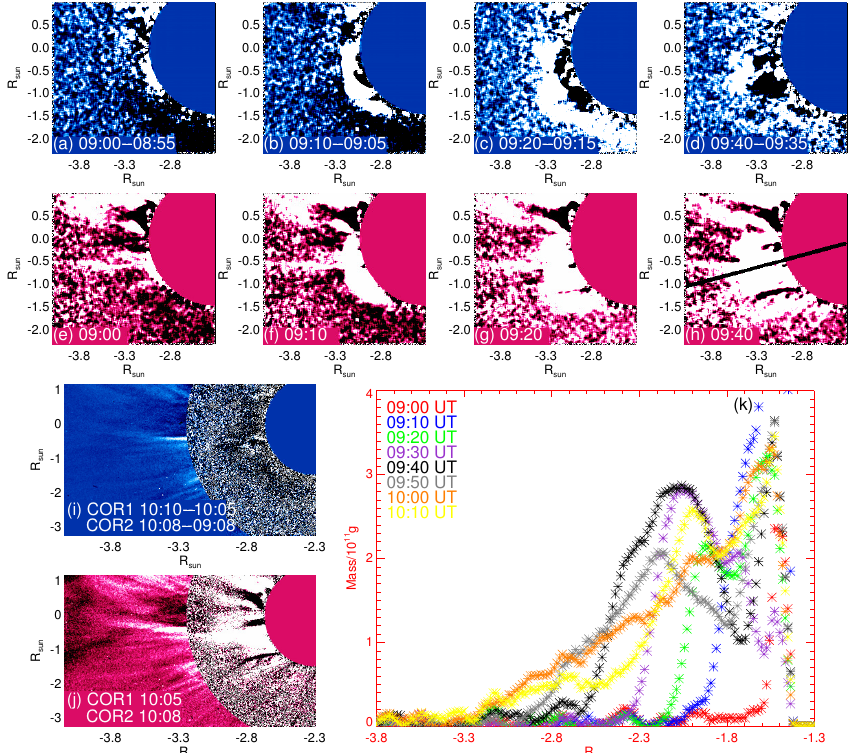
Figure 2. The first (Panel a – d ) and third row (Panel i ) is the running difference brightening image, and the second (Panel e – h ) and fourth row (Panel j ) is the mass distribution image recorded by STEREO-A COR1/COR2. The unit of all images is the solar radius from the solar center. (Panel k ) shows the mass profile along the black line as shown in panel